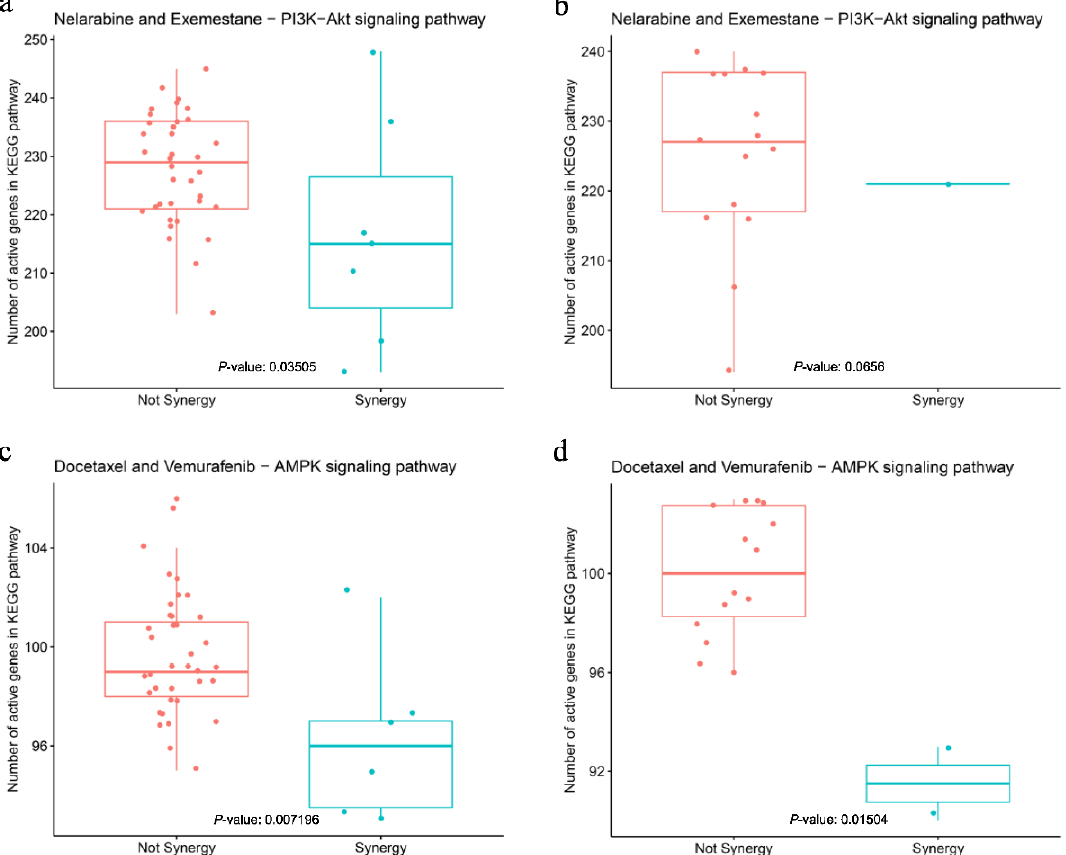
Figure 7. Box plot of the number of active genes in the KEGG pathway. The lines in the box are First quartile (Q1), Medium (Q2), and Third quartile (Q3). ( a , c ) training data; ( b , d ) validation data.